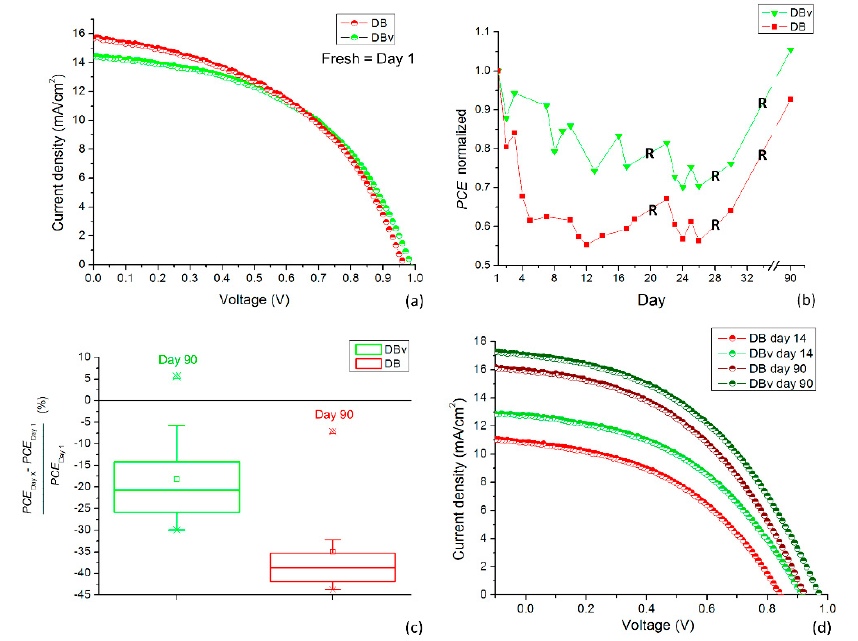
Figure 2. Performances over time in DB-PSC and DBv-PSC: ( a ) Current density-voltage (J-V) curves of representative doctor-blading (DB)-PSC and DBv-PSC at day 1, i.e., with fresh devices; ( b ) PCE trend along 30 days and after 60 days storage in dark condition and nitrogen environment. “R” in the figure indicates the partial recovery of performance due to dark storage in nitrogen environment for a time ≥ 4 days; ( c ) Box plot of PCE Percent variations with respect to the value of day 1; ( d ) J-V curves of representative DB-PSC and DBv-PSC (as in Figure 2a) at day 14 and day 90. Measurements were taken on the same device for each type (DB-PSC and DBv-PSC). Table 2. Photovoltaic parameters of representative DB-PSC and DBv-PSC on day 1 (fresh), day 14 (worst condition), and day 90 taken on the same device for each type (DB-PSC and DBv-PSC). V OC (V) J SC (mA / cm 2